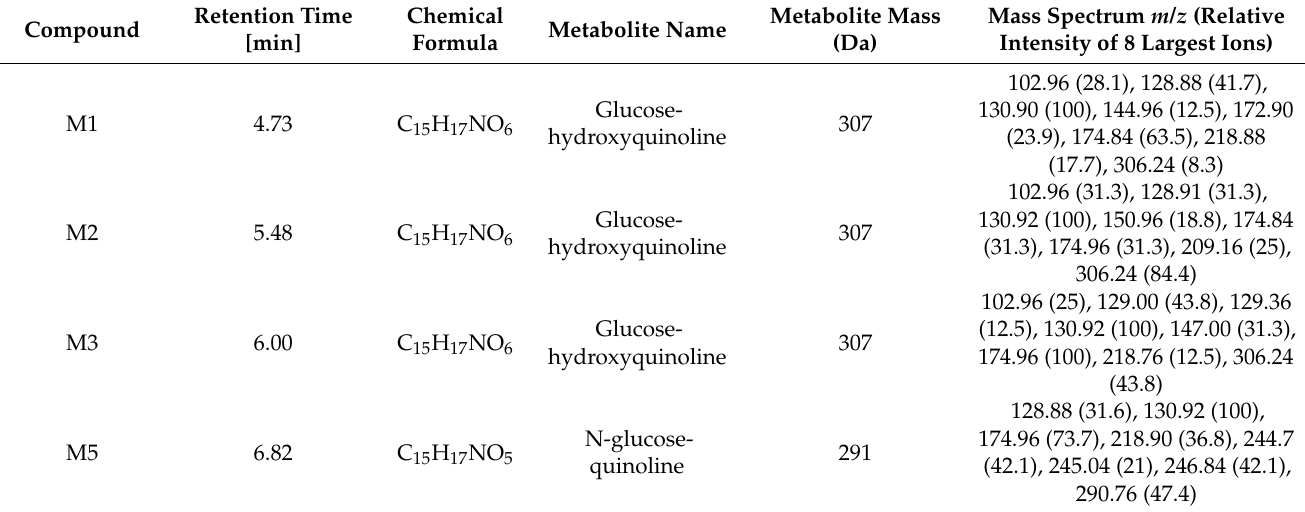
Table 1. LC-MS/MS results of quinoline biotransformation by C. lunata IM 4417.